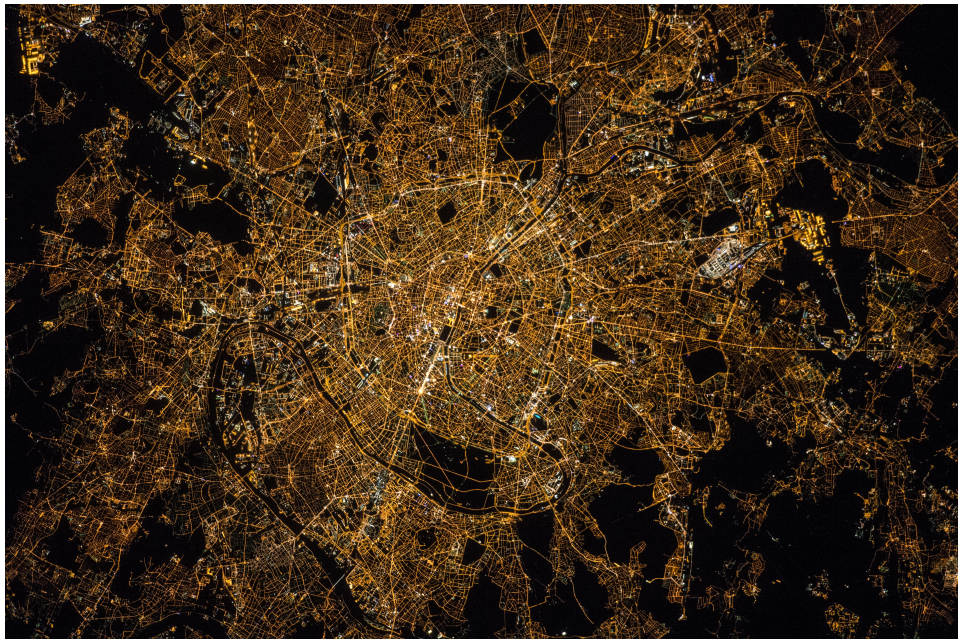
Figure 1. Paris at Night acquired by an astronaut from the ISS. (NASA Photo ID